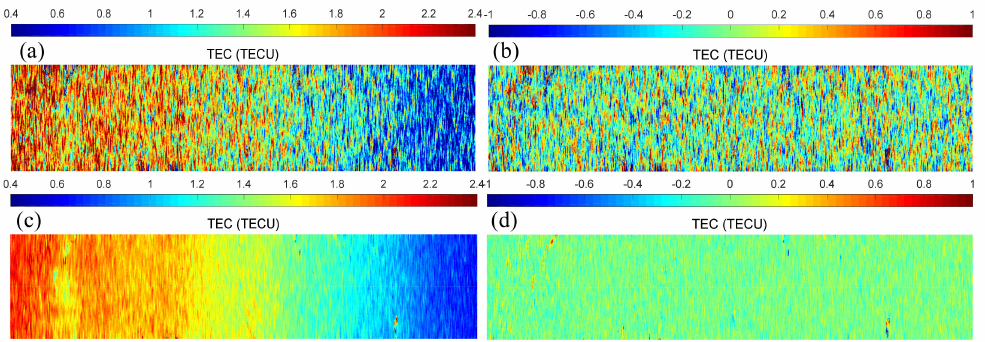
Figure 3. TEC retrieval in Ottawa based on L-band SAR ( a ) and P-band SAR ( c ), with high systematic error level. The deviations between the retrieval and the true values (Figure 1b) are shown in ( b , d ).